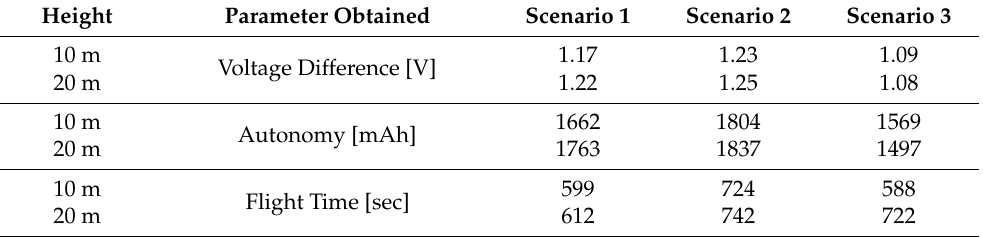
Table 9. Average results from Case Study